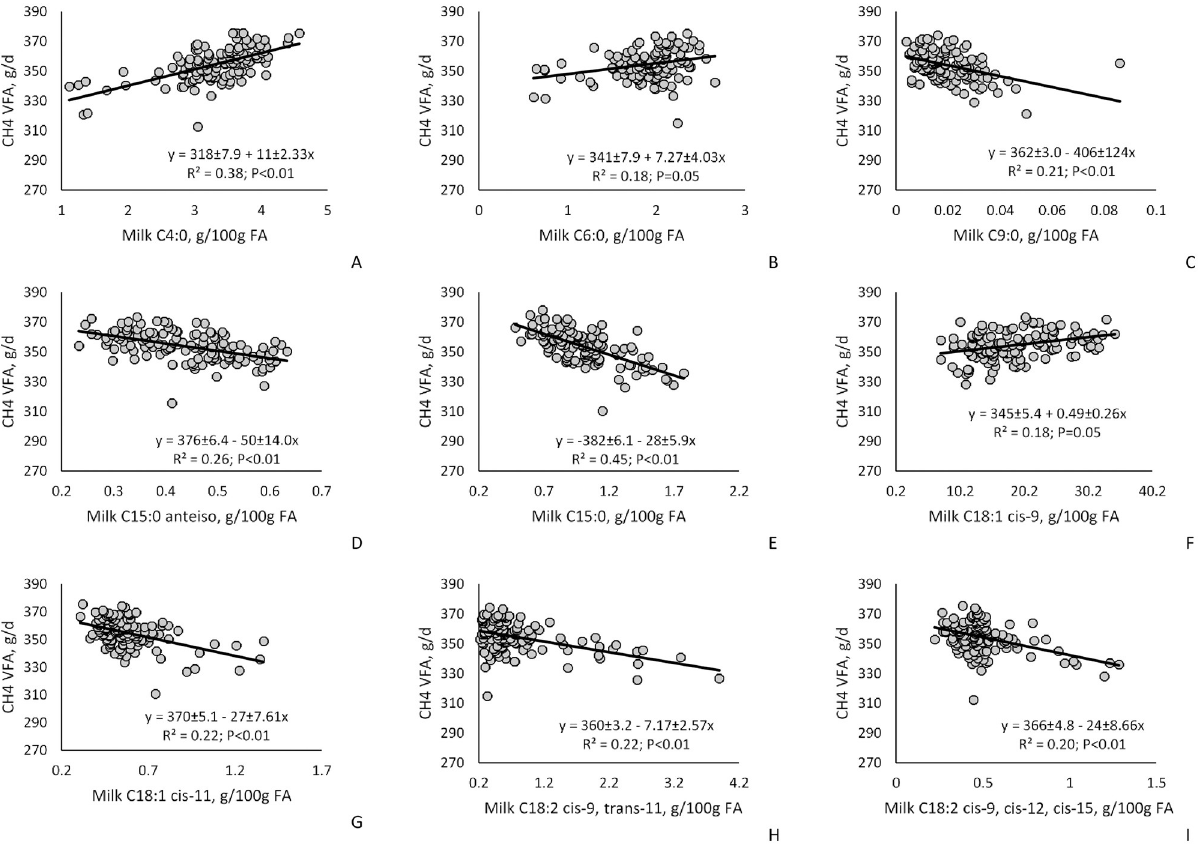
Fig 1. Influence of selected milk fatty acid (FA) on Y_CH 4 VFA estimated by univariate mixed model regression analysis (CH 4 VFA = A + BX 1 ) in dairy cows.